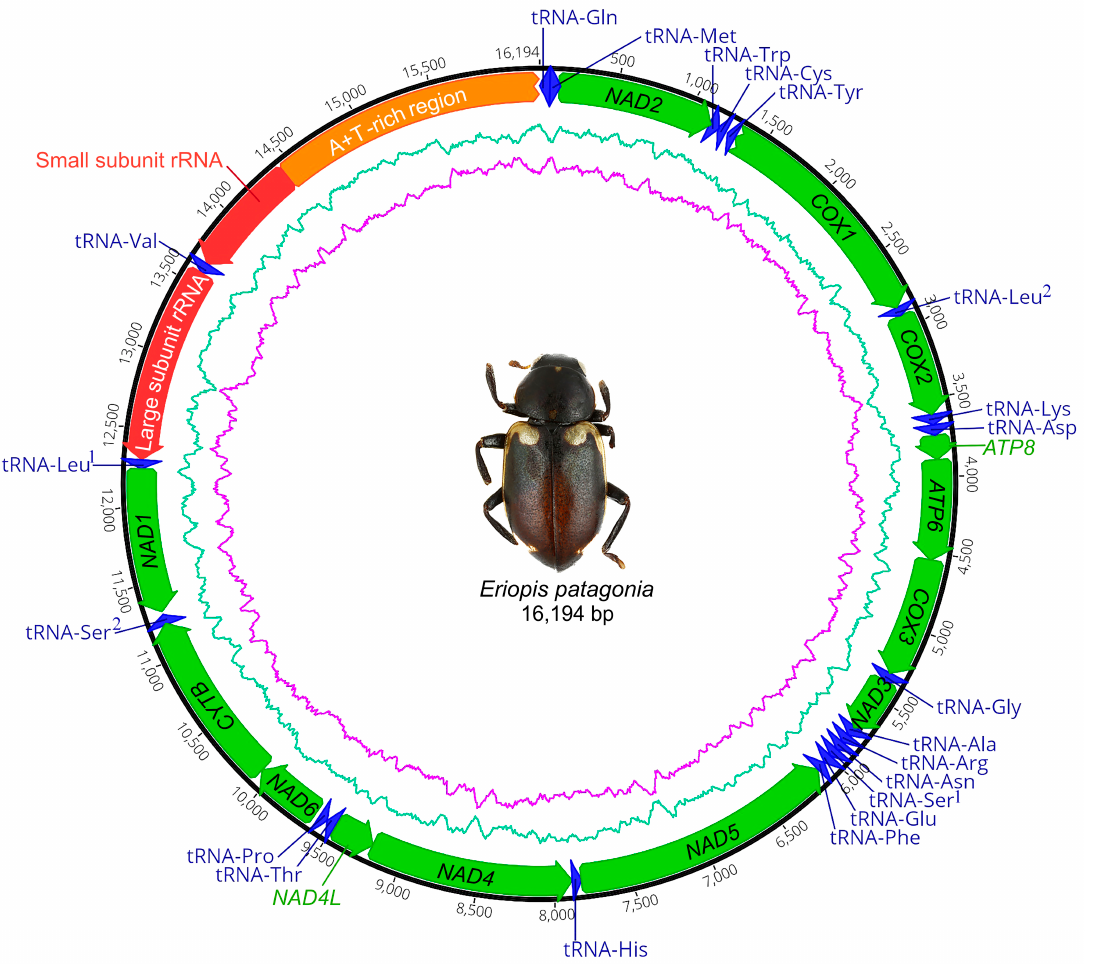
Figure 6. Map of the mitochondrial genome of Eriopis patagonia Salazar, sp. nov. The 13 protein-coding genes (PCGs) are shown in green, the 21 transfer RNA (tRNAs) are shown in blue, the two ribosomal RNA (rRNAs) are shown in red, and the A + T rich region is shown in orange. The direction of transcription is indicated by an arrow. Graphic representation of AT (green-blue) and GC (pink) content (%) and their changes throughout the mitogenome.